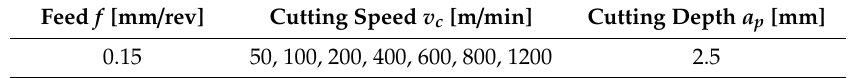
Table 2. Plan of the non-free orthogonal grooving test employed for an evaluation of surface topography.